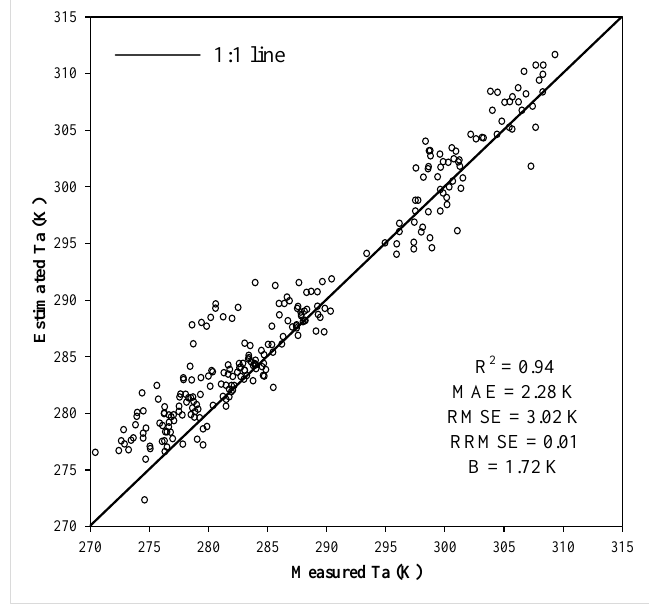
Figure 4. Scatterplots of estimated and measured T a